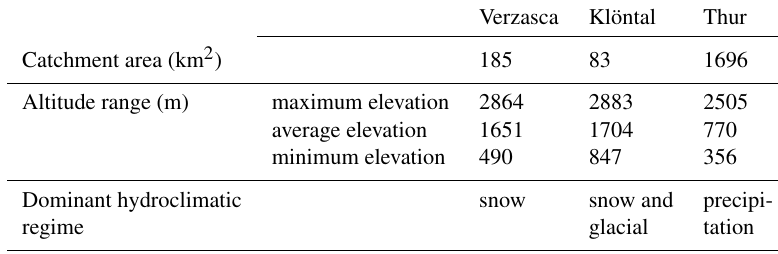
Table 1. Overview of the catchment characteristics for the three catchments